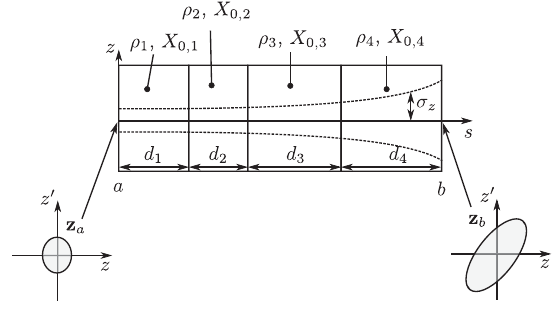
FIG. 3. The initial beam phase space z a will evolve to z b after scattering through N slabs of thickness, density, and radiation . length d i , (cid:8) i , and X 0 ;i